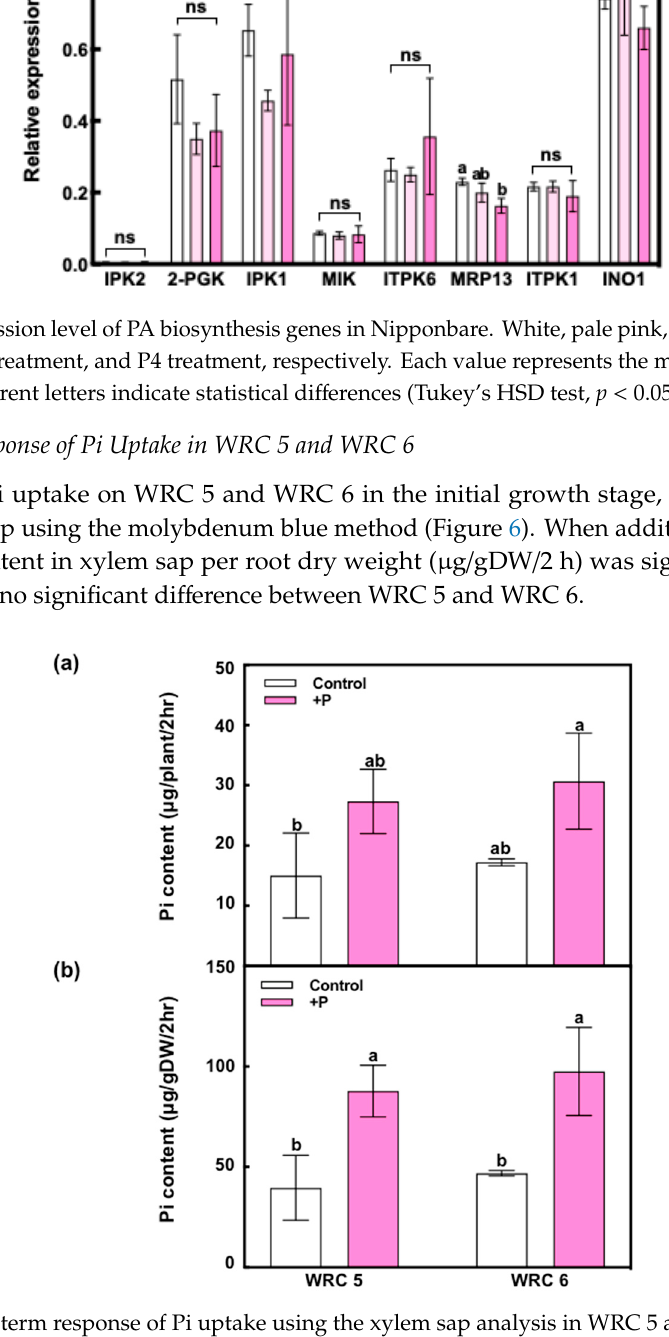
Figure 6. Short-term response of Pi uptake using the xylem sap analysis in WRC 5 and WRC 6. ( a ) Pi content in xylem sap oozed out from one seedling for 2 h ( μ g/plant/2 h) and ( b ) Pi content per root DW ( μ g/gDW/2 h). White and pink indicate the control and P treatment, respectively. Each value represents the mean ± SD of three replicates. Different letters indicate statistical differences (Tukey’s HSD test, p < 0.05).